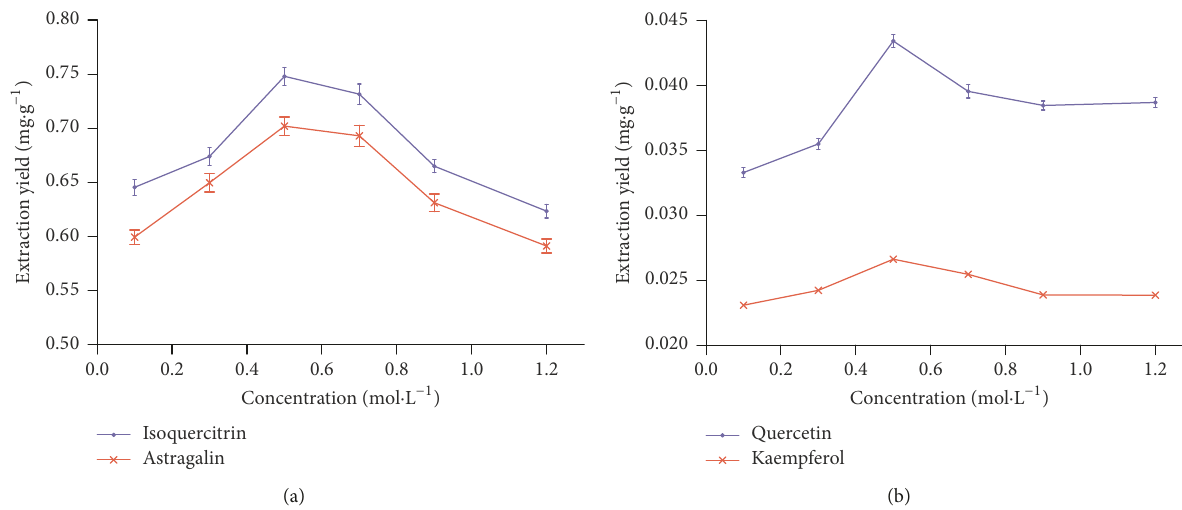
Figure 4: Effect of the concentration of IL on extraction yields. Type of IL: [BMIM]BF 4 ; the particle size: 50 mesh; solid-liquid ratio: 1:10g ⋅ mL −1 ; ultrasound time: 30min; ultrasound power: 500 W; centrifugation speed: 5000 r ⋅ min −1 .